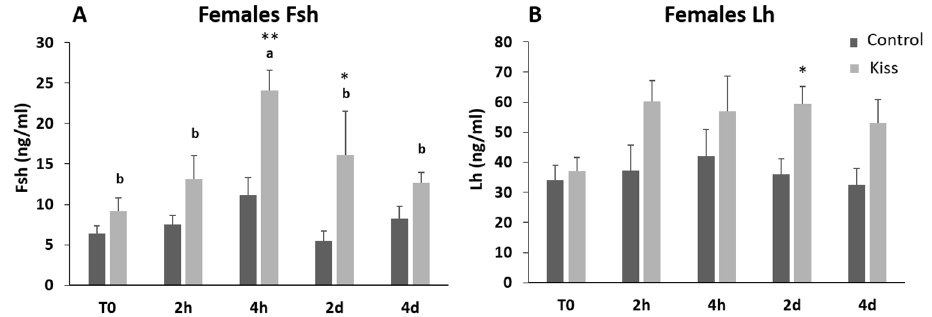
Figure 2. Gonadotropin plasma levels in ng/mL (mean ± standard error of the means, SEM) from Senegalese sole females treated with kisspeptin hormone ( n = 15) and controls ( n = 17). ( A ) Fsh and ( B ) Lh levels before (T0) and after (2 h: 2-h; 4 h: 4-h; 2 d: 2-days; 4 d: 4-days) the kisspeptin injection. The asterisk denotes significant differences between experimental groups at each sampling point (Student’s t -test; * p < 0.05; ** p < 0.002); different letters indicate significant differences among sampling points within each experimental group (one-way ANOVA, Dunnett’s test, p < 0.05, T0 considered as control point).